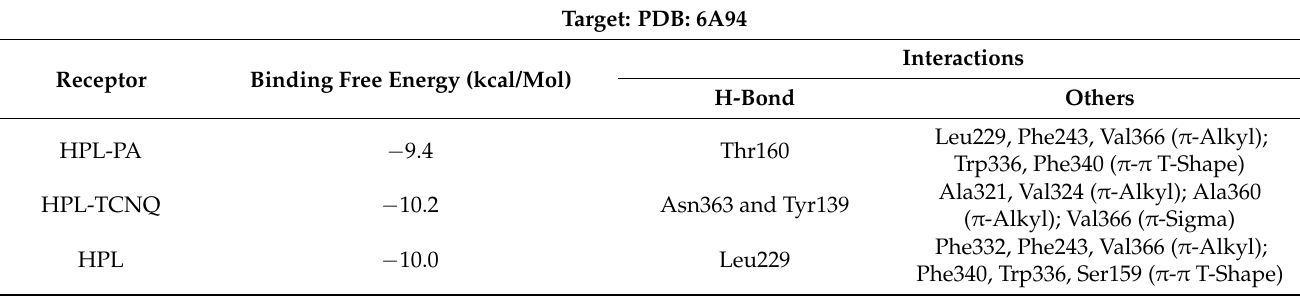
Table 1. Docking score of the ligands and their interactions with serotonin (6A94).